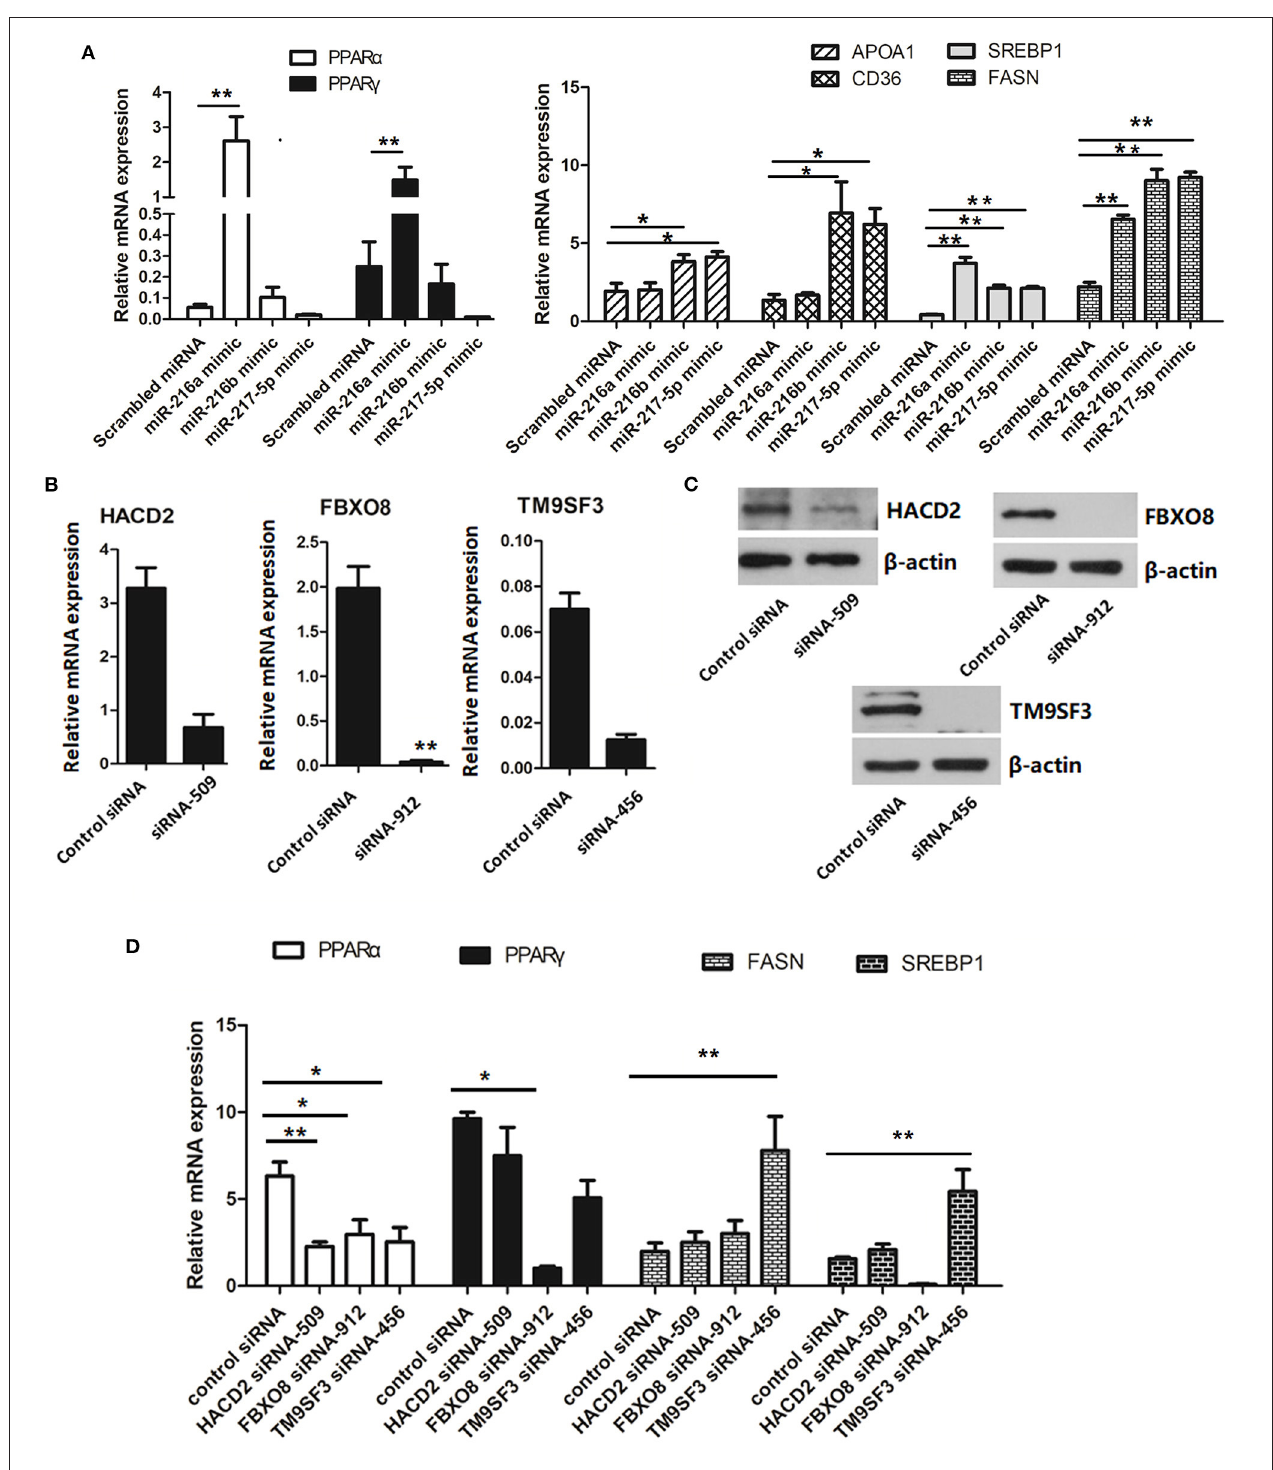
FIGURE 5 | Relative mRNA levels of genes associated with lipid metabolism (A) relative mRNA levels of genes involved in the PPAR/SREBP signaling pathway in LMH cells transfected with miRNA mimics. (B) Validation of the siRNAs for silencing of HACD2 , FBOX8 , and TM9SF3 by RT-qPCR analysis. (C) Validation of the siRNAs for silencing of HACD2 , FBOX8 , and TM9SF3 by immunoblotting analysis. (D) RT-qPCR analysis of genes associated with the PPAR/SREBP signaling pathway in target-inhibited LMH cells. The results are presented as the mean and standard error of at least triplicate experiments. * P < 0.05 and ** P < 0.01.